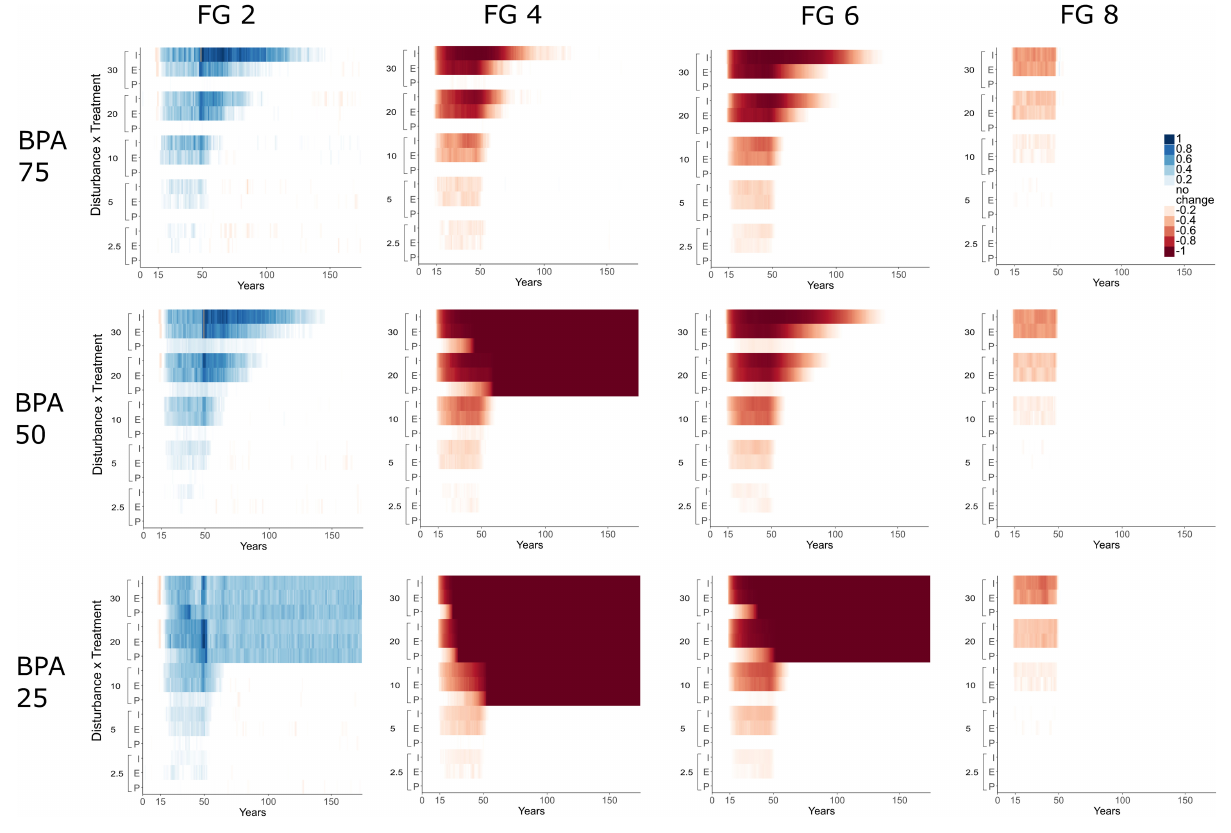
FIGURE 7 | Proportion significant increase/decrease of adults compared to baseline pre-disturbance levels (mean ± 95% confidence interval) [shown as a color ranging from dark blue (1; proportion has doubled); no significant change (0; white); dark red (–1; FG has been extirped)] over time for four functional groups (FG 2, 4, 6, and 8 – columns) across models with varying BPA protection extent (25, 50, and 75% of the total model area – results for 90% were excluded because these did not differ substantially with those shown with 75% impact extent). Model seafloor areas [protected (P), Edge disturbance (E), and Inner disturbance (I)] are shown grouped by disturbance (2.5, 5, 10, 20 and 30% disturbance per year for 35 years – starting at year 15 and finishing at year 50) on the y -axis of each